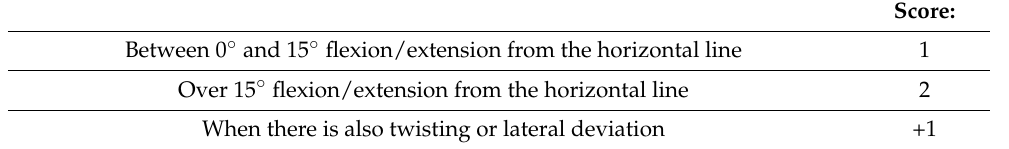
Table 6. Score Increase.